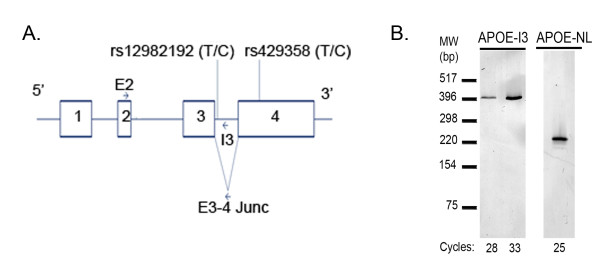
PCR Detection of APOE-NL and APOE-I3. PCR primer positions are depicted relative to the four exons of APOE (A). Two SNPs are also shown: rs12982192 within intron 3 and rs429358, which determines APOE4 status, in exon 4. PCR of 25 or 28-33 cycles was used to detect APOE-NL and APOE-I3, respectively, in pooled brain cDNA samples (B).